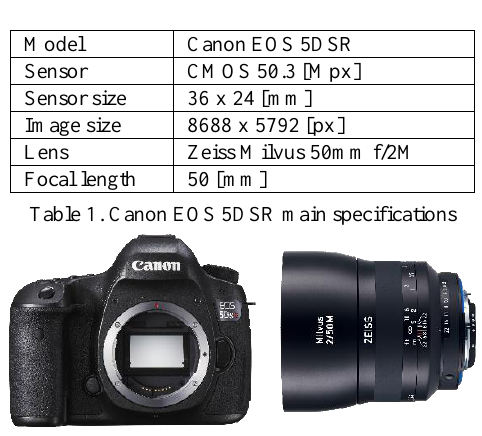
Figure 2. On the left, the full-frame high resolution DSLR camera used during data acquisition (Canon EOS 5DSR). On the right, Zeiss Milvus 50mm f/2M macro lens